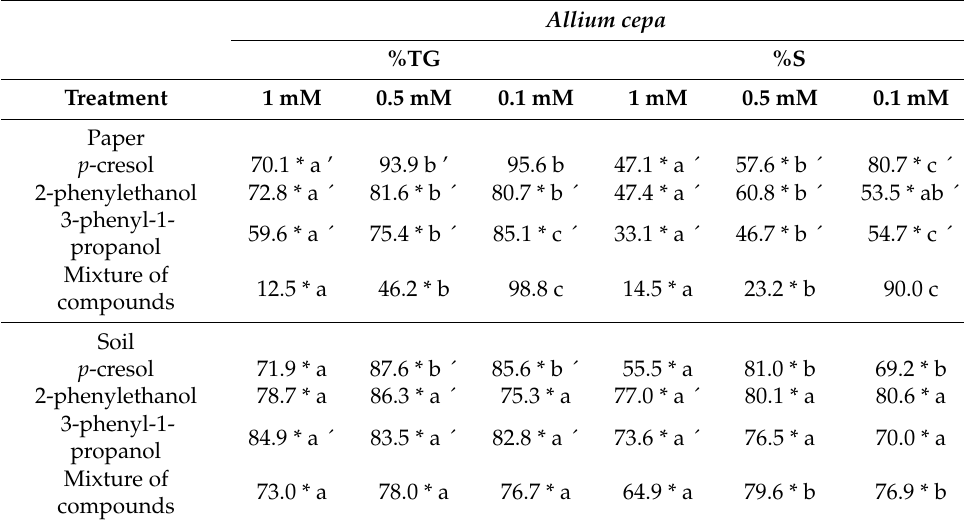
Table 1. Effect of different concentrations of phenolic compounds from the Cistus ladanifer exudate on Allium cepa germination (%TG) and germination rate (%S), expressed as the percentage relative to the control. Four replicates of each treatment ( n = 4 × 50 = 200 seeds in total for each solution). Allium cepa %TG